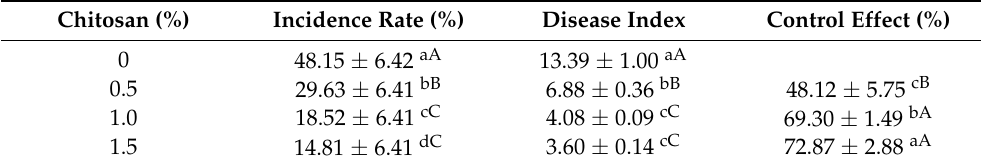
Table 1. The inducing control effects of chitosan against Sphaerotheca sp. of R. roxburghii